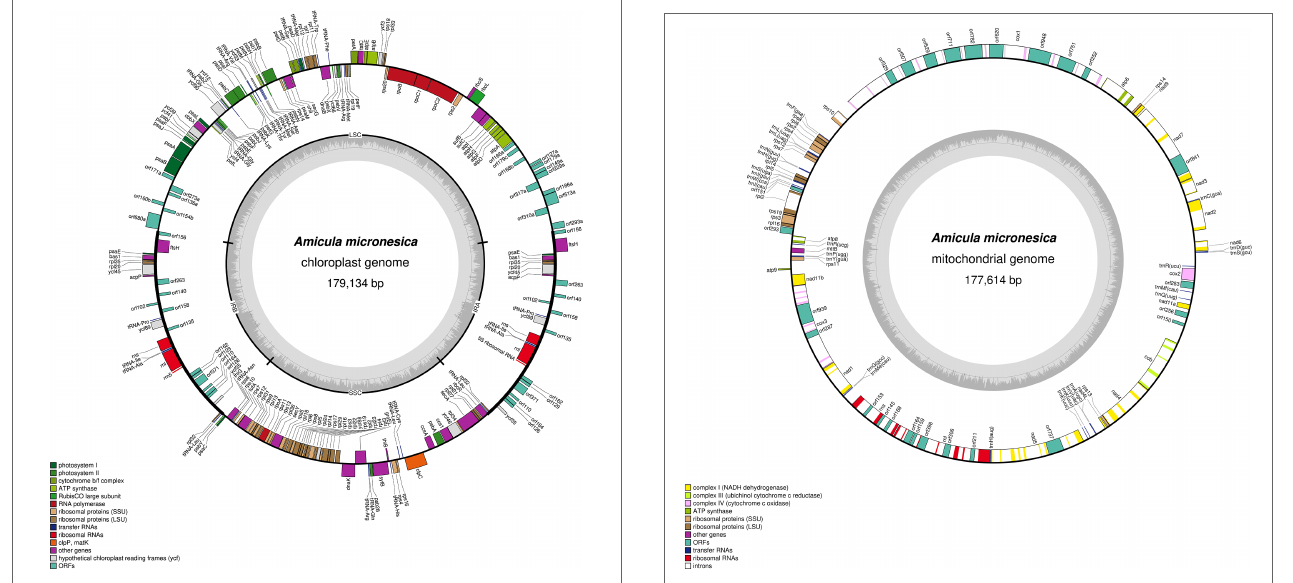
FIGURE 6 | Map of the plastid genome of Amicula micronesica. FIGURE 7 | Map of the mitochondrial genome of Amicula